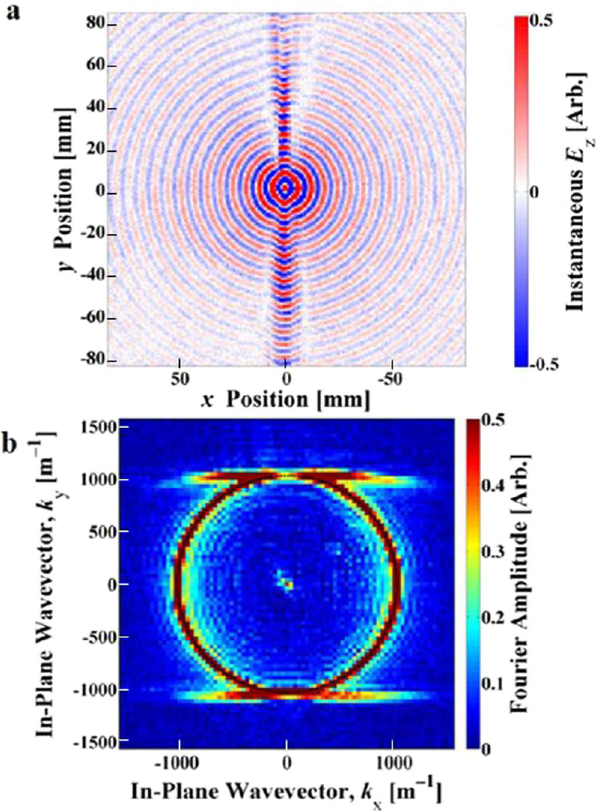
Figure 3. Experimental near-field scan results showing beaming at 49.15 GHz, with the excitation at the centre of the plot. ( a ) Real space plot of instantaneous E z ; ( b ) Iso-frequency contour plot of the in-plane wave vector components of the surface wave. Colour scales are